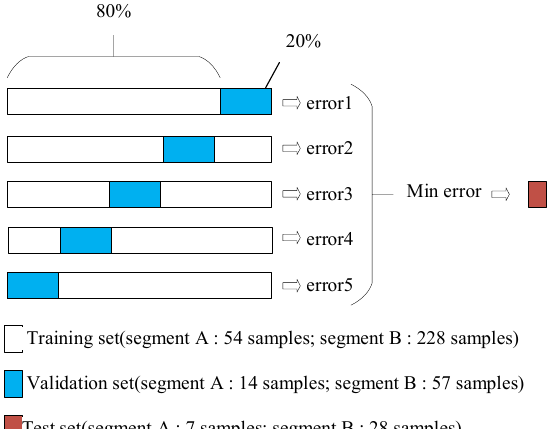
Figure 3. Dataset partitioning.